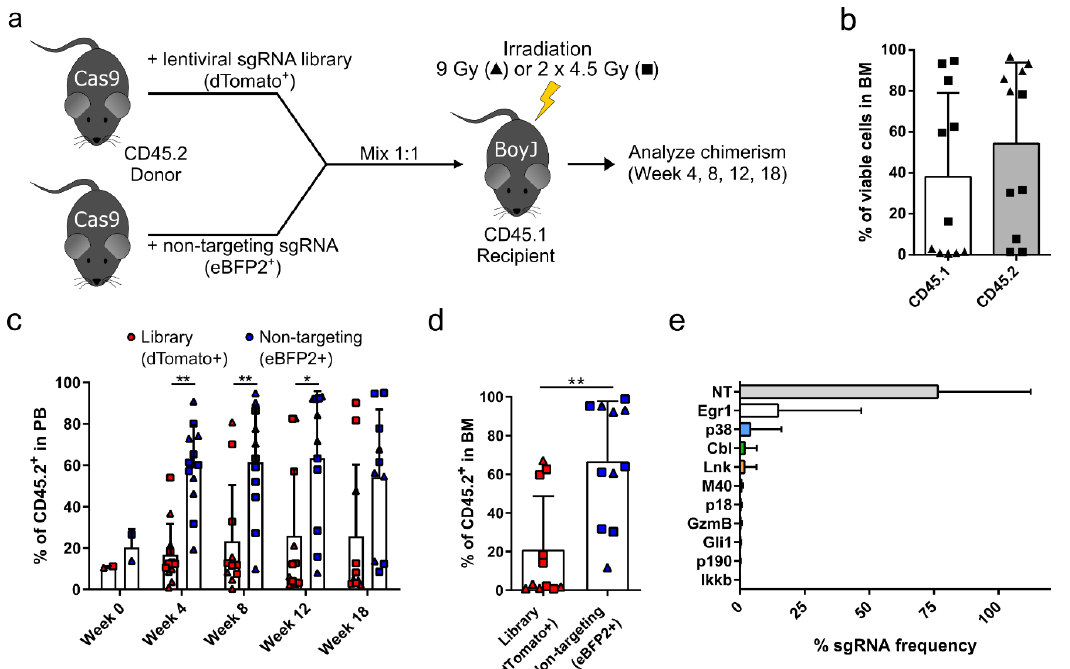
Figure 1. Targeted sgRNA screen identified potential candidate genes that mediate a competitive advantage during bone marrow transplantation. ( a ) Scheme of competitive bone marrow transplantation. Donor cells were derived from CD45.2 + Cas9 mice and were transduced with a lentiviral sgRNA library and a dTomato fluorescent reporter. CD45.2 + Cas9 competitor cells were transduced with a nontargeting sgRNA and eBFP2 fluorescent reporter. Donor cells were mixed 1:1 and transplanted into irradiated CD45.1 + recipient mice. Recipient mice were irradiated with either a single dose of 9 Gy (triangles) or a fractionated dose of 2× 4.5 Gy (squares). Peripheral blood of the transplanted mice was analyzed on weeks 4, 8, and 12 after transplantation. Final analysis was performed 18 weeks after transplantation. ( b ) Donor cell chimerism was analyzed in the bone marrow 18 weeks after transplantation. ( c ) The presence of dTomato + cells (red) carrying the sgRNA library and eBFP2 + competitor cells (blue) was monitored over time in peripheral blood. ( d ) The frequency of dTomato + cells carrying the sgRNA library and eBFP2 + competitor cells was analyzed in the bone marrow on week 18 after transplantation. ( e ) The sgRNA frequency of each candidate gene in the library was assessed via next-generation sequencing in bone marrow samples of recipient mice 18 weeks after transplantation. NT = nontargeting. Statistics: n = 11, mean ± SD, two independent experiments, t -test ( b , d ), two-way ANOVA comparing row means only ( c ), * p < 0.05, ** p < 0.01.